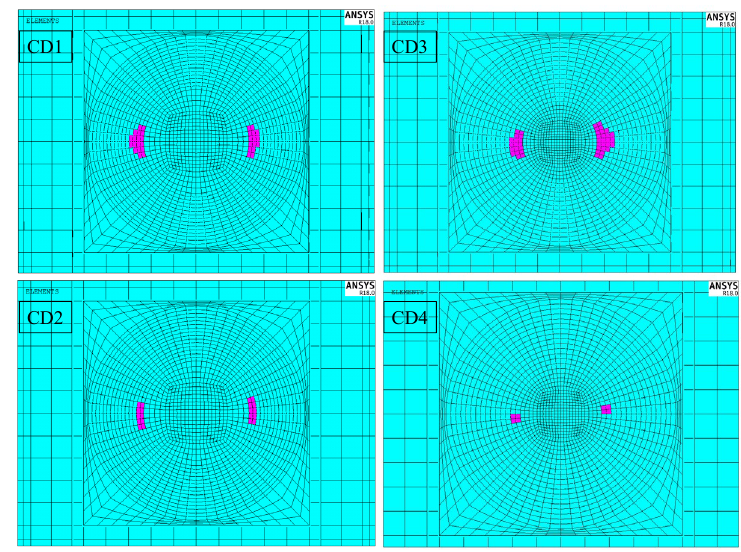
Figure 6. CD1– CD4 configurations: ( a ) delaminated area vs. load curves; ( b ) delamination evolution at final analyses load ( pink represent the delaminated area).